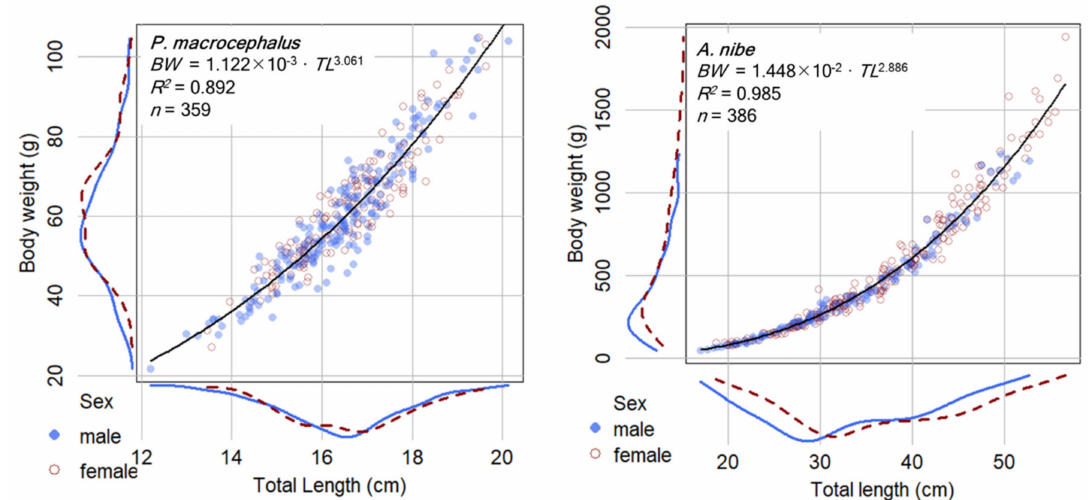
Figure 4. Total length (TL) and body weight (BW) data and the estimated length-weight equation of P. macrocephalus and A. nibe . The blue lines and circles are male, and the red lines and circles are female.